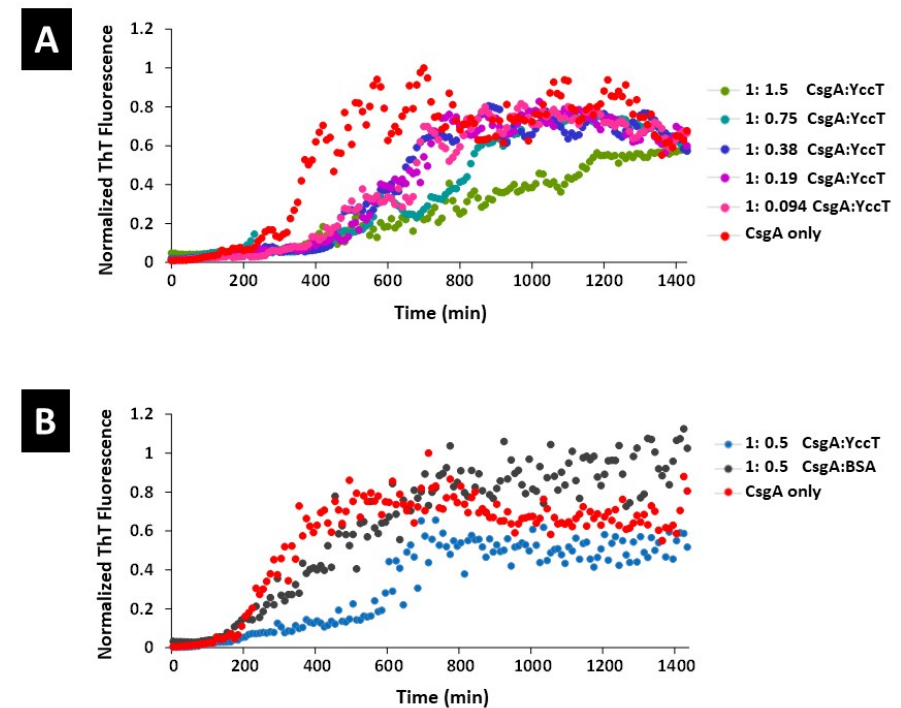
Figure 4. Detection of CsgA amyloid formation by ThT assay. ( A ) Samples of purified CsgA only or mixture of purified CsgA and YccT (ratios CsgA/YccT of 1.5, 0.75, 0.38, 0.19, or 0.094) were incubated at room temperature. The fluorescence intensity was determined every 10 min using the formula indicated in the text and was plotted on a graph. ( B ) Samples of purified CsgA only, purified CsgA (same volume) and YccT (0.5 times the amount of CsgA), or purified CsgA and BSA (0.5 times the amount of CsgA) as control were analyzed as described in ( A ). Each graph is representative of two independent experiments.